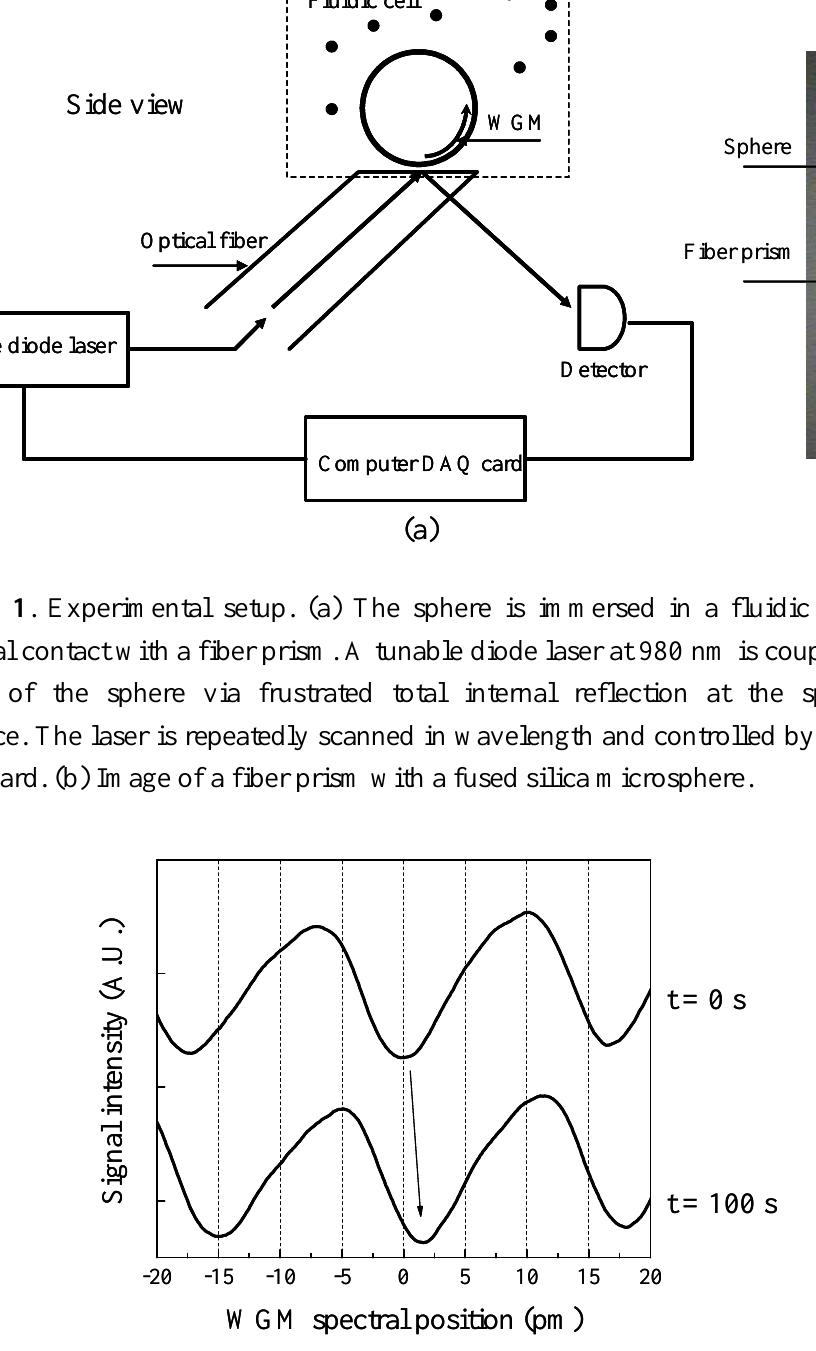
Figure 2. WGM spectral position shifts as bio/chemical molecules attach to the surface over time. The lines are shifted vertically for